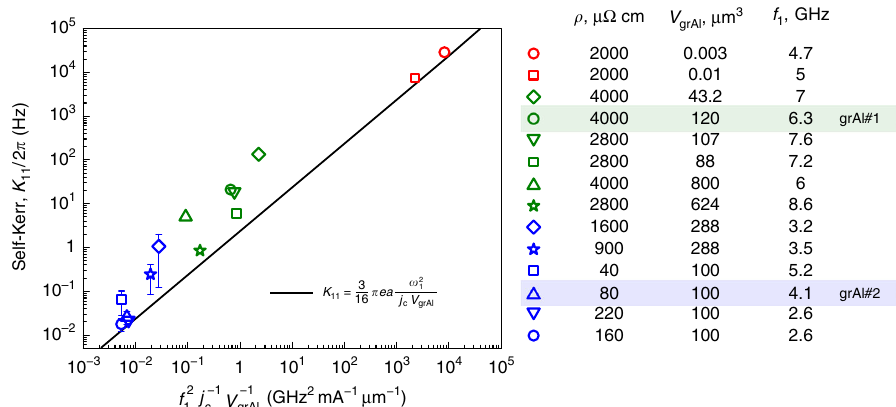
= j V , where f 1 = ω 1 /2 π is the 1 c grAl